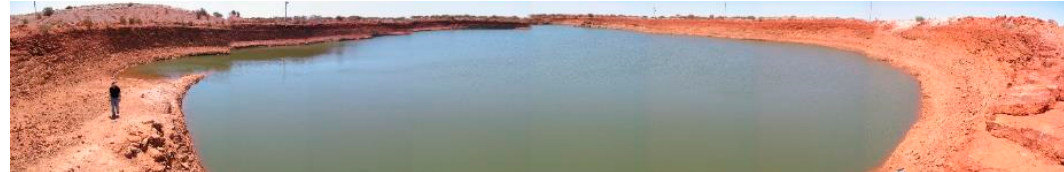
Figure 6. Wedge Pit Lake in arid Western Australia is used as a municipal potable water supply for the nearby town of Laverton.